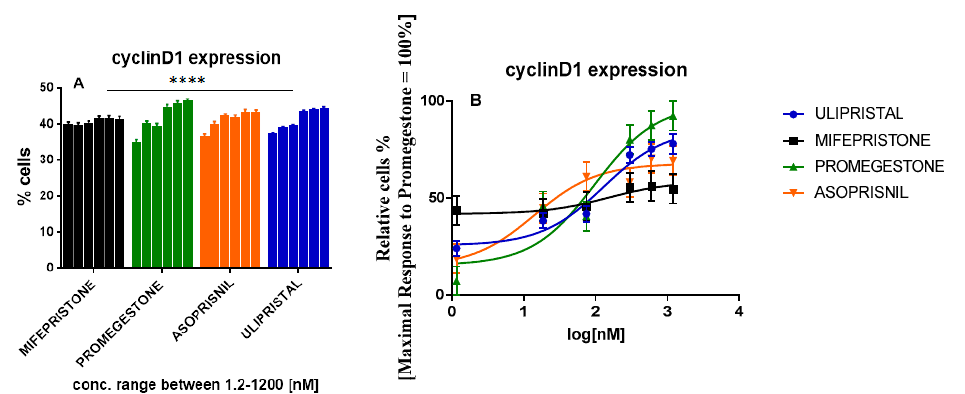
Figure 3. The tested compounds induced cyclin D1 expression in T47D cells during treatment for 24 h; A: FACS analysis of cells population with cyclin D1 expression, data represent three separate experiments, n = 3 , mean ± SD with statistic significant **** p ≤ 0.0001 (two-way ANOVA for comparison of tested groups against each other, mean volumes for each concentration were analyzed, data for the control group although statistically significant, there was not published) ; B: normalized % of cells with cyclin D1 expression to maximal % of cells expressing cyclin D1 upon Promegestone stimulation.